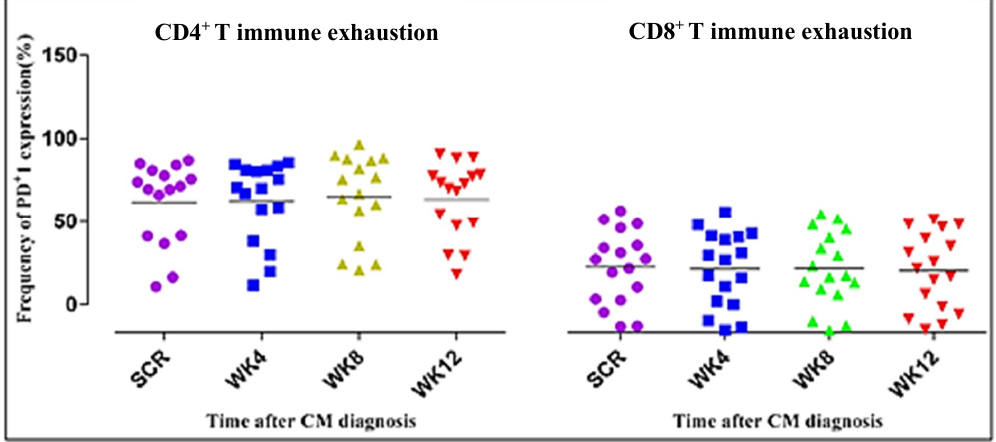
Figure 6. Immune exhaustion levels remained elevated for CD4 + and CD8 + T cell subpopulations.